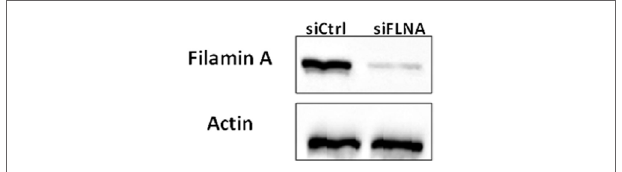
FigUre 12 | Western blot analysis of FLNA expression in FLNA-silenced cells. ECC-1 cells were transfected with 10 µM control siRNA (siCtrl) or FLNA siRNA (siFLNA) for 96 h. Cells were lysed and extracts (100 µg) were electrophoresed and immunoblotted with an antibody against FLNA. Actin levels were measured as a loading control. The figure shows the results of a typical experiment, repeated three times with similar